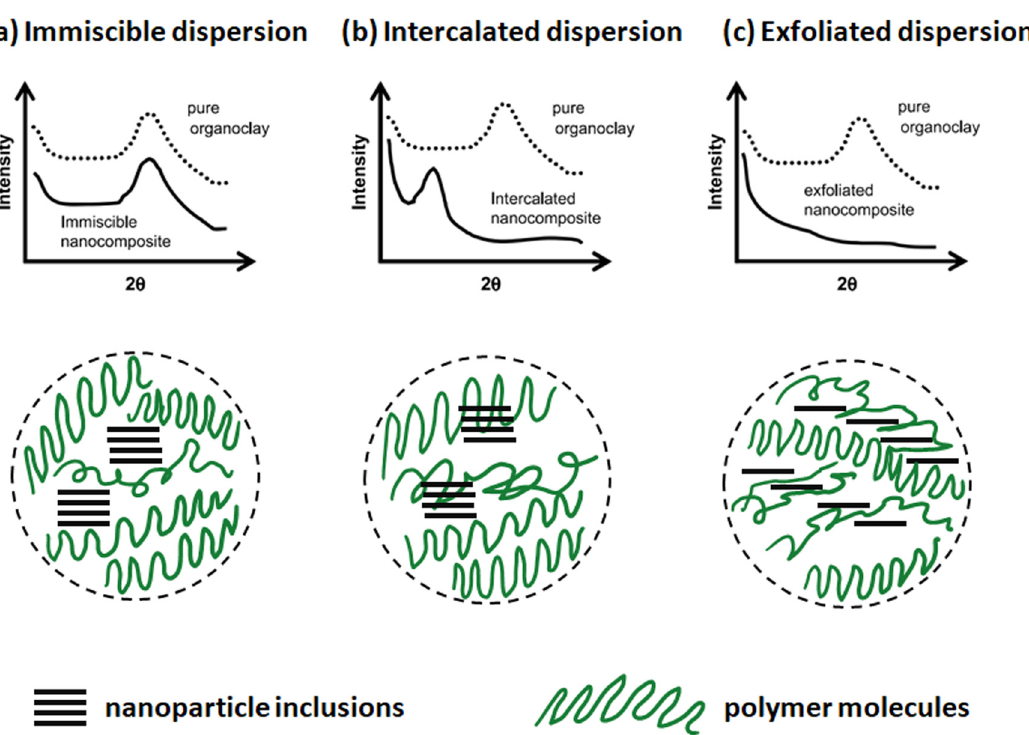
Figure 2: Schematic illustration of di ff erent states of dispersion of nanoparticle inclusions in polymeric matrix with corresponding WAXS: ( a ) immiscible; ( b ) intercalated; ( c ) exfoliated. Adopted from ref. [ 48,49 ] with modi fi